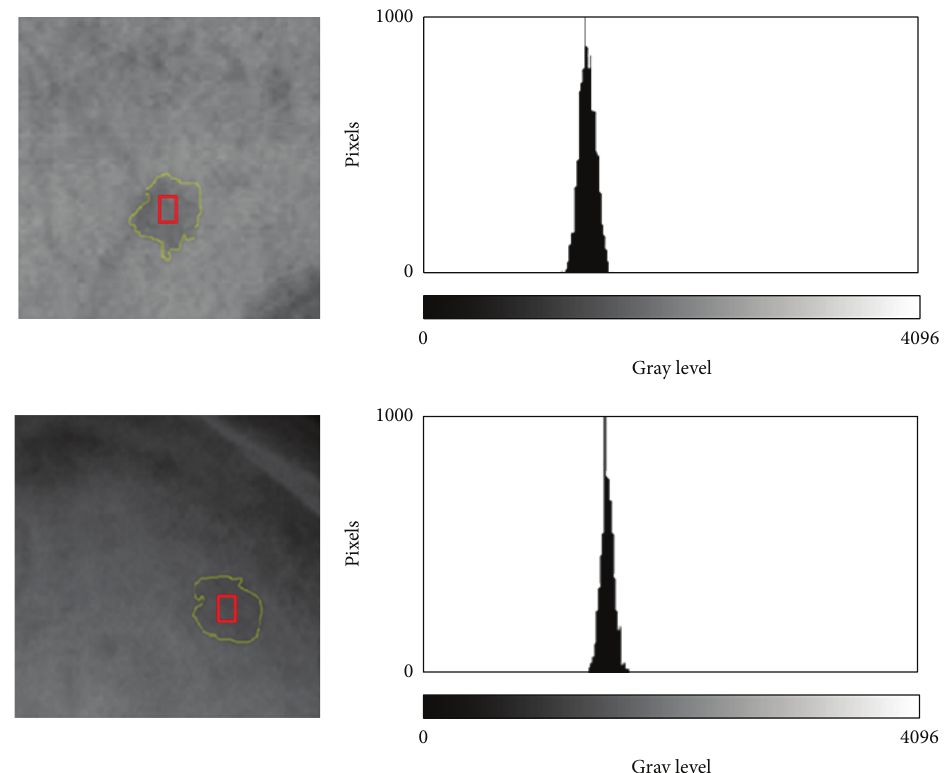
Figure 1: Two zooms of different plain radiographs showing osteolytic regions of interest (ROI). Gray level histogram for the outlined ROI is shown on the right side for each case. (a) Multiple myeloma (case 3, skull); (b) lytic metastasis (case 7, skull).